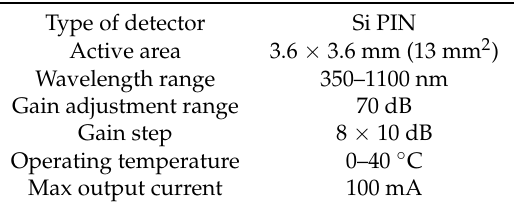
Table 2. Chosen parameters of photodetector